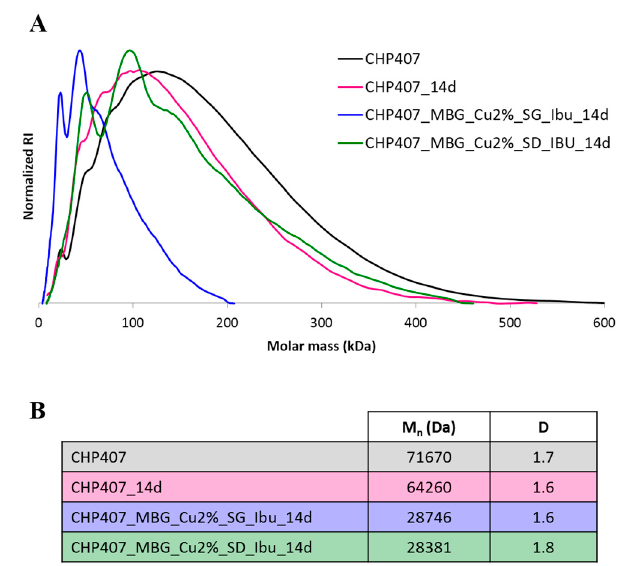
Figure 6. Molecular weight distribution (normalized refractive index (RI) vs. molar mass) ( A ) and estimated M n and D values ( B ) of as synthesized CHP407 and residual CHP407 collected from CHP407, CHP407_MBG_Cu2%_SG_Ibu and CHP407_MBG_Cu2%_SD_Ibu gels incubated in aqueous medium for 14 days.